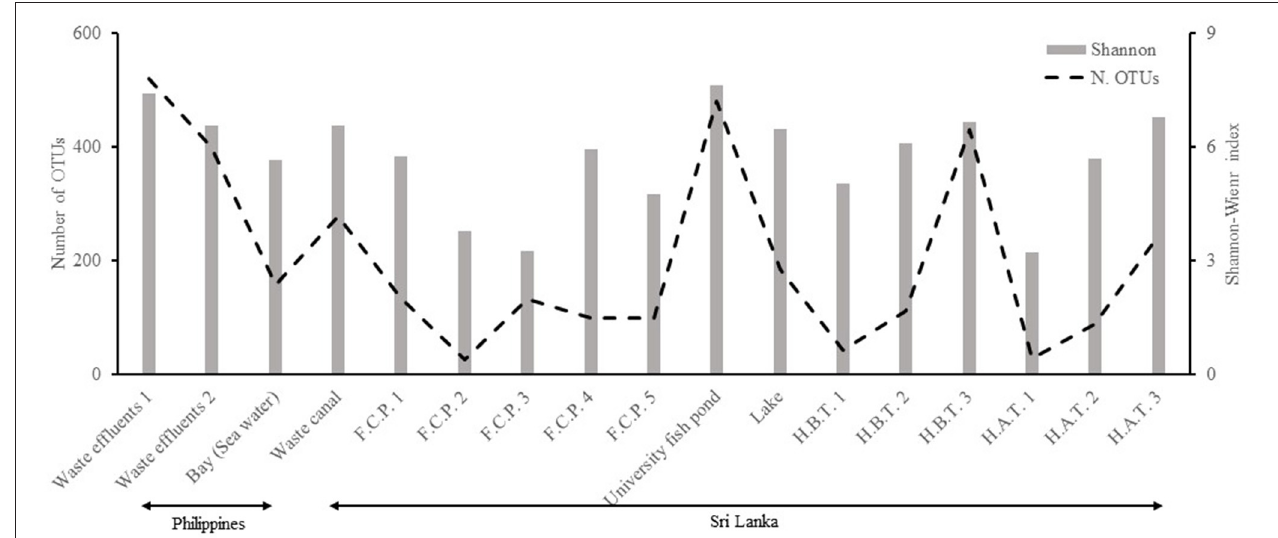
FIGURE 3 | Principal coordinate analysis (PCoA) of 16S rRNA genes in water samples according to the Bray–Curtis method. The information of sample type is available in Table 1 .